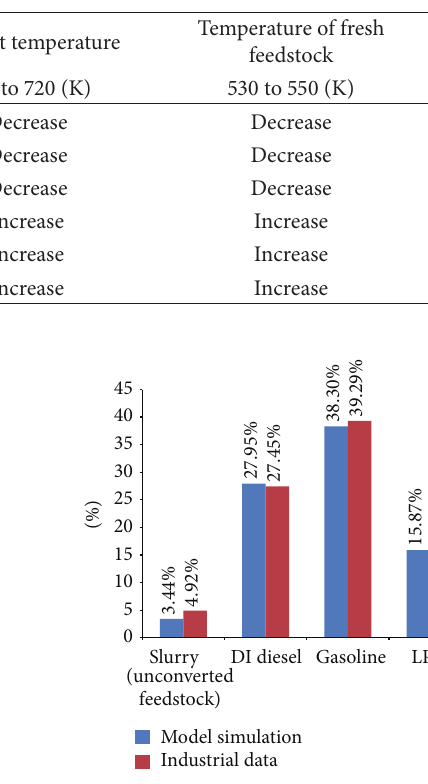
Table 5: General behavior of the multipurpose pilot unit U-144 studied.